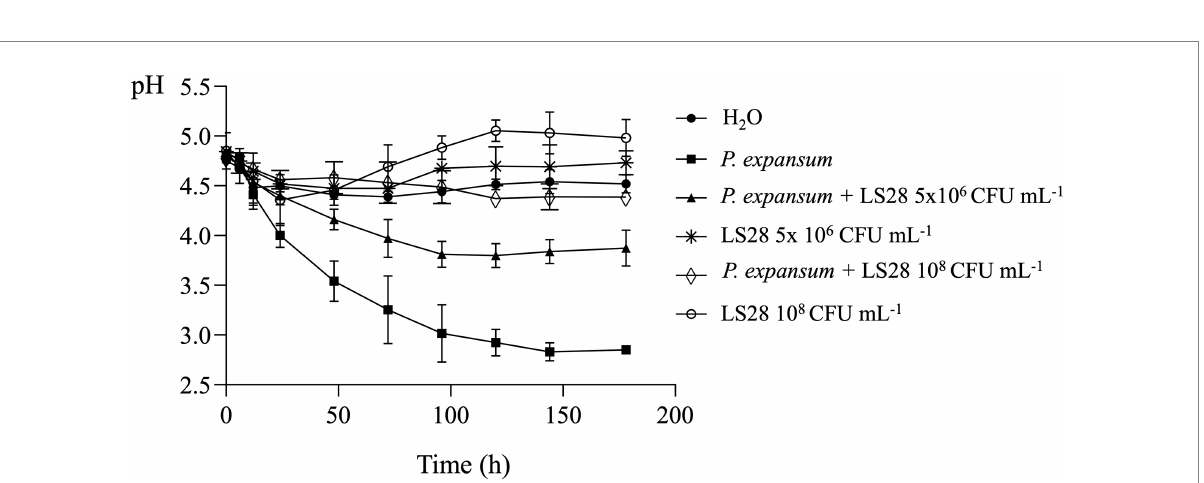
FIGURE 5 In vivo extracellular pH trend in apple wounds inoculated with optimal (10 8 CFU ml − 1 ) and suboptimal (5 × 10 6 CFU ml − 1 ) concentrations of the biocontrol yeast Papiliotrema terrestris LS28 and with the fungal pathogen Penicillium expansum strain 7015. pH was measured at 0, 6, 12, 24, 48, 72, 96, 120, 144, and 178 h after inoculation. Data shown are the mean values ± SD from three independent experiments.